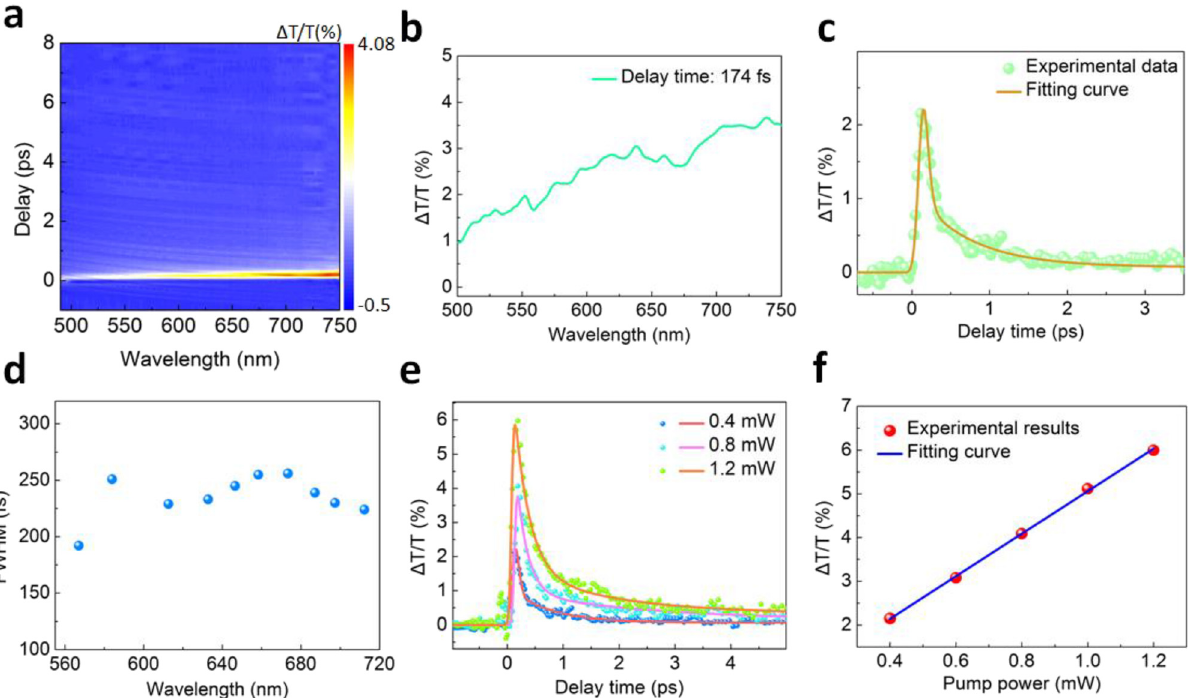
Figure 3: The experimental results of the pump-probe method. (a) Differential transitivity spectra of MXene versus short wavelength of probe light and delay time. (b) Differential transitivity spectra of the MXene at the delay time of t = 174 fs. (c) The dynamic curves and fi tted results of the MXene at 567 nm. (d) Full width at half maximum as a function of the wavelength of the probe light. (e) The dynamic curves under different pump power. (f) The pump power dependence of differential transitivity at 622 nm with linear fi